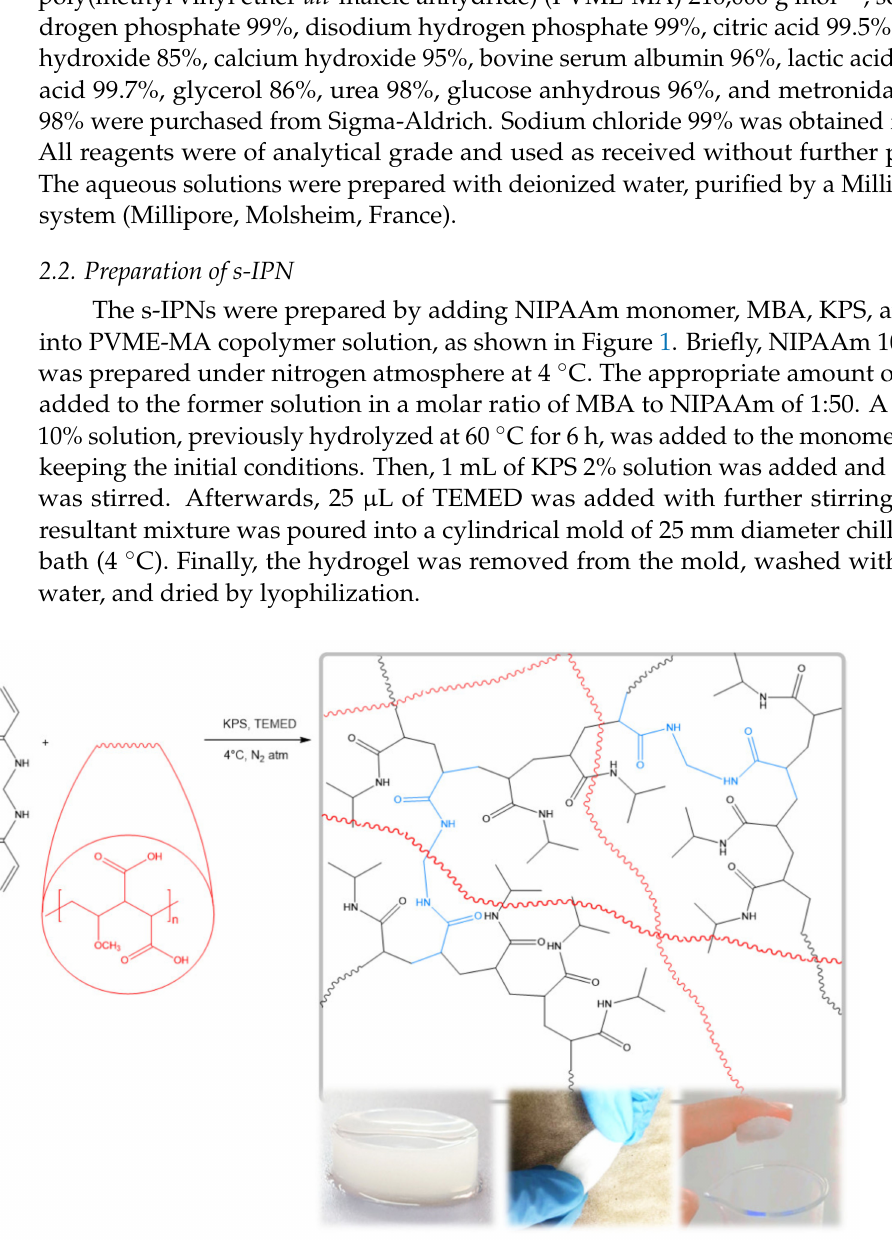
Figure 1. Schematic representation of s-IPN formation. The photographs illustrate, from left to right, the appearance of as-formed composite hydrogels, the ease of handling of dehydrated samples, and the sticky nature of wet